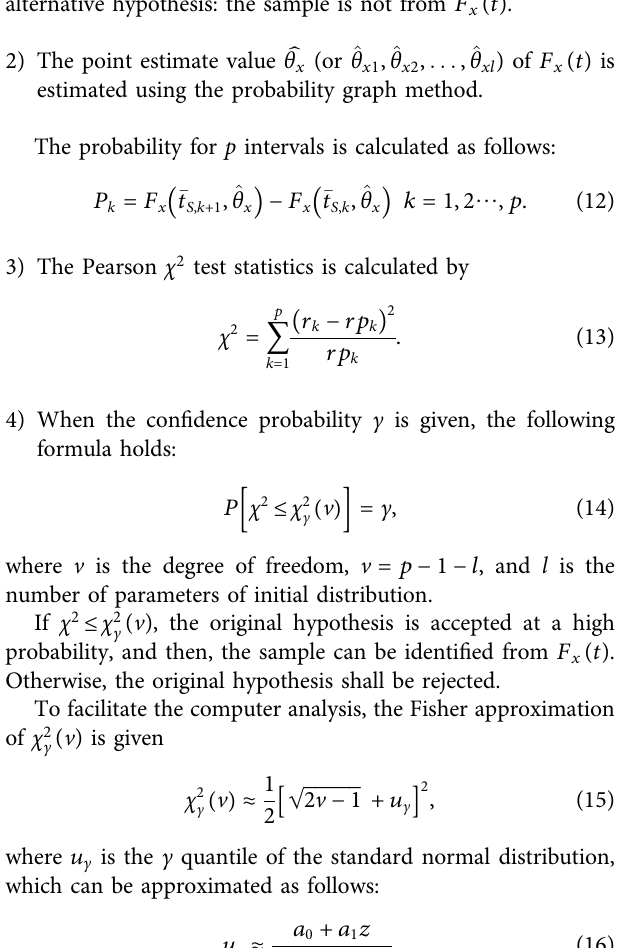
Table 3 , the life simulation value for each unit is generated using the simulation conversion equation in Table 1 . We set r (cid:2) 500, and the 500 life simulation values for units are obtained as listed in Table 4 (excerpt). 500 life simulation values for the system are obtained through logical